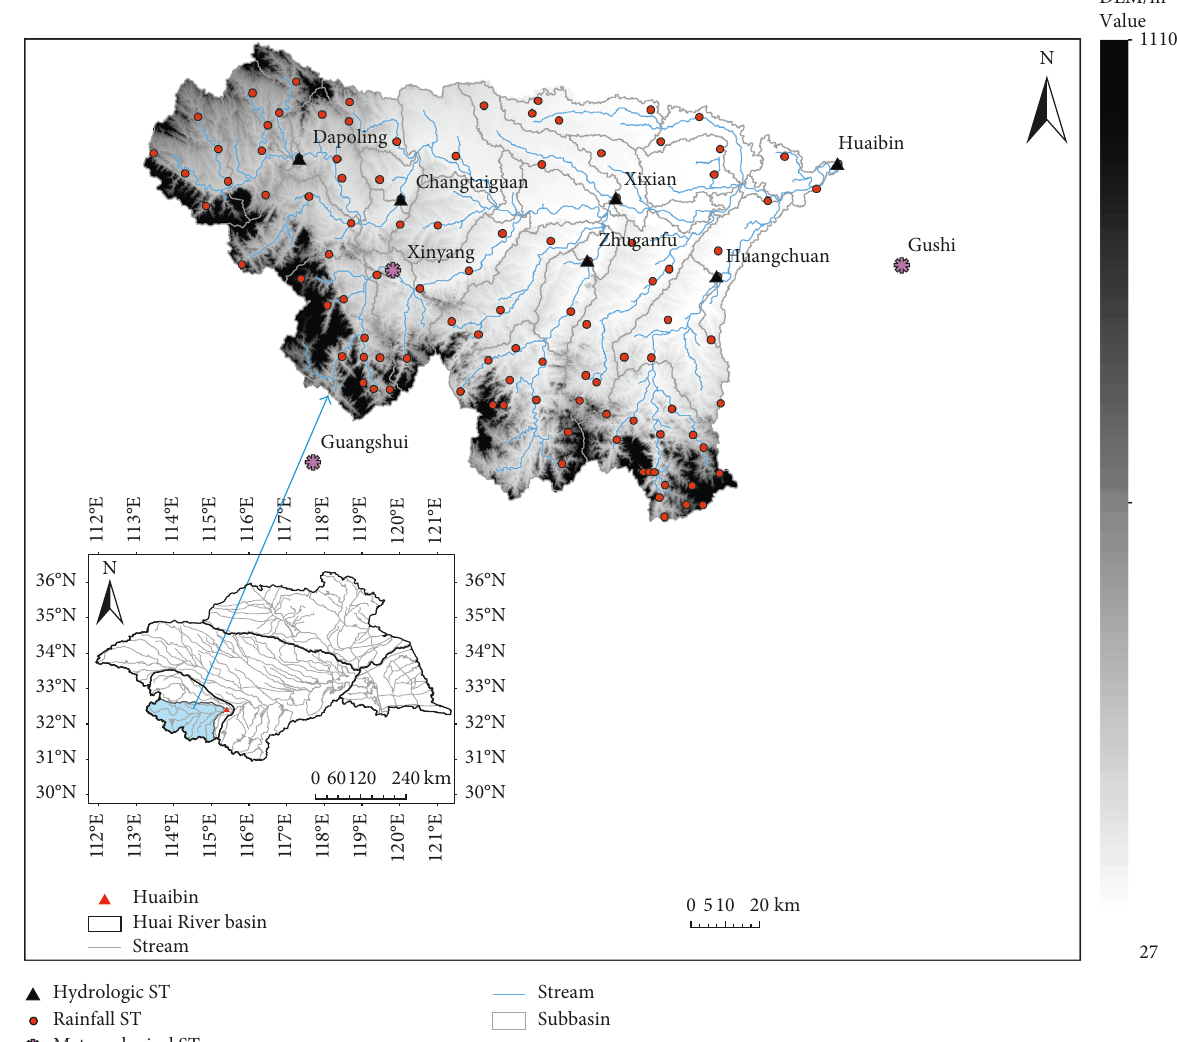
Figure 1: The upper Huai River basin: location (the inset map), elevation, digital river network, location of the meteorological and hydrological stations (ST), and the subbasin delineation in SWAT model